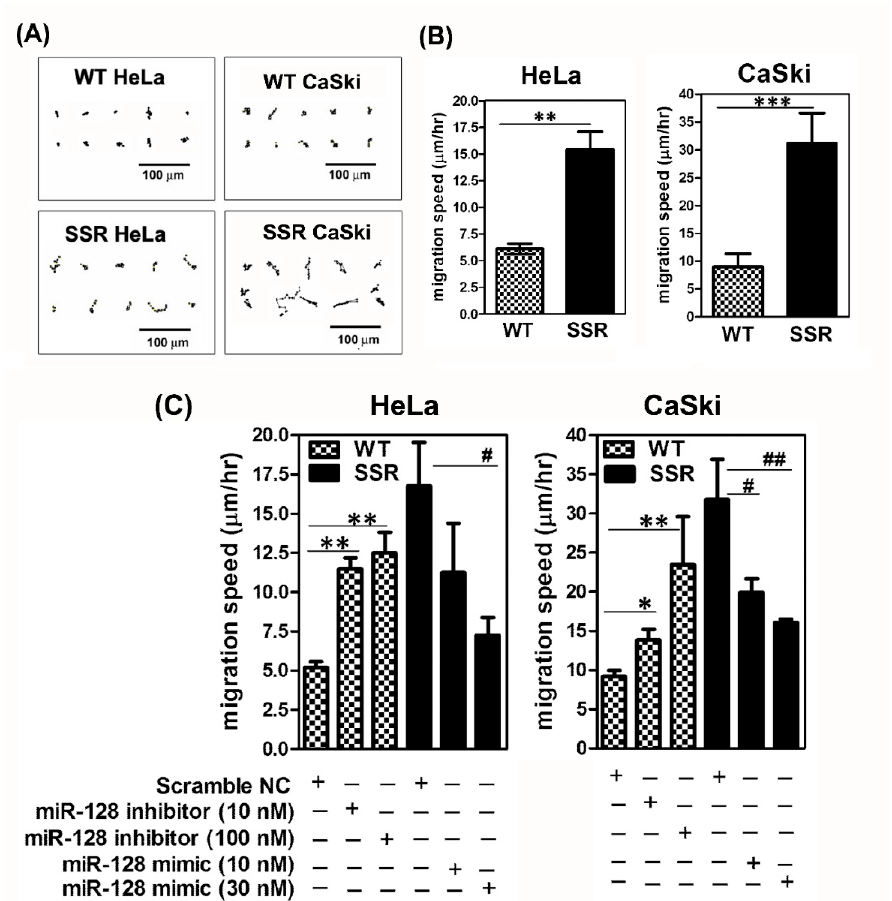
Figure 4. Shear stress-resistant CaSki and HeLa cells exhibited enhanced cell mobility in vitro and forced overexpressed miR-128 suppressed SSR-augmented cervical cancer cell migration. ( A ) Representative cell migration trace from a time-lapse recording of cell migration over 8 h. The result was representative of various independent clones of WT and SSR clones of HeLa and CaSki cells. Scale bar, 100 μ m. ( B ) Summary of migration speed by time-lapse recording assay of the migration of HeLa and CaSki cells over 8 h. Data are shown as mean ± SD. All the experiments were repeated three times and calculated from at least 20 cells per field for individual samples; eight fields from each experiment were counted from at least two repeated experiments. ** P < 0.01, *** P < 0.001 for the SSR group vs. WT group. ( C ) HeLa or CaSki cells were transfected with miR-128 inhibitor oligonucleotides, miR-128 mimic oligonucleotides, or scramble negative control oligonucleotides for 48 h; then we performed the time-lapse recording assay. Each dataset was reported as the mean ± SD; * P < 0.05, ** P < 0.01 for the WT + miR-128 inhibitor group vs. WT + scramble NC group and SSR + miR-128 mimic group vs. SSR + scramble NC group. # P < 0.05, ## P < 0.01 for the SSR + miR-128 mimic group vs. SSR + scramble NC group .